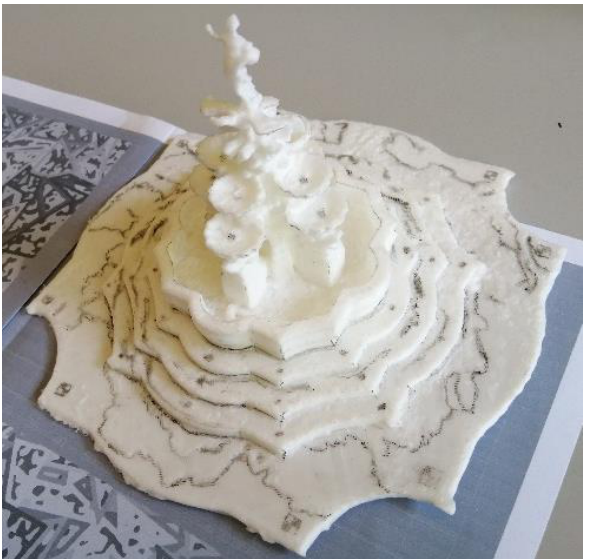
Figure 8. The 3D printed model of the Garraffo fountain with the targets drawn on the surface.